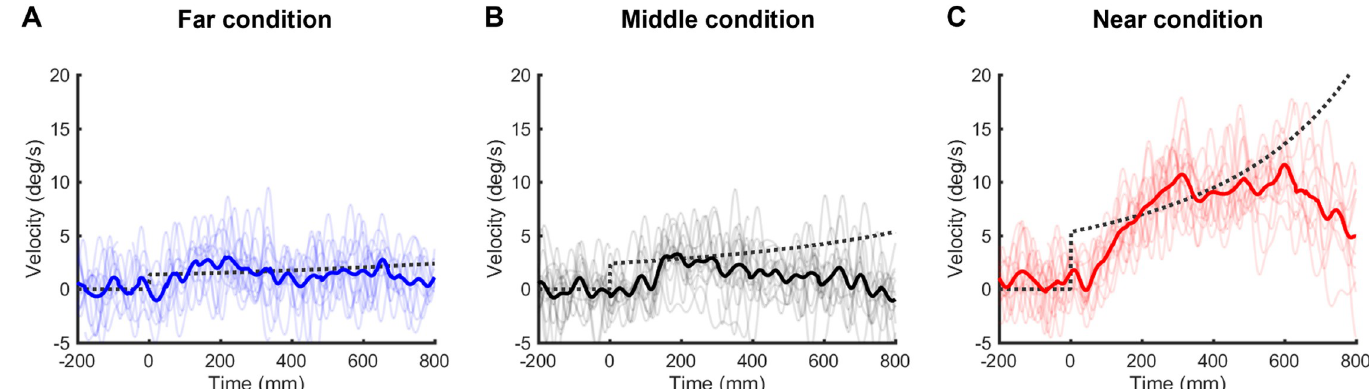
Fig 11. Typical examples of the velocity of convergence eye movements at target velocity of 25.0 cm/s for the eye movement task in the far (A), middle (B) and near (C) conditions. The thin and thick lines indicate the velocity for each trial and the mean velocity, respectively. The dotted lines indicate target velocity.